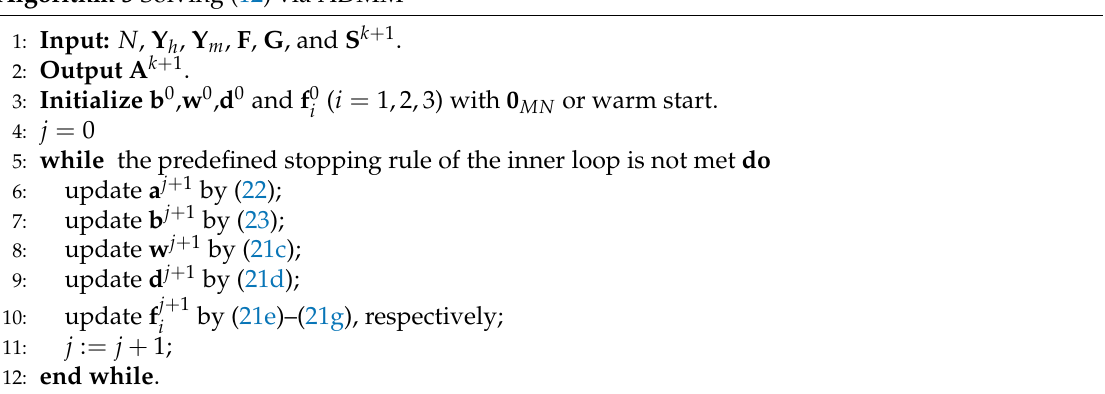
Algorithm 3 Solving (12) via